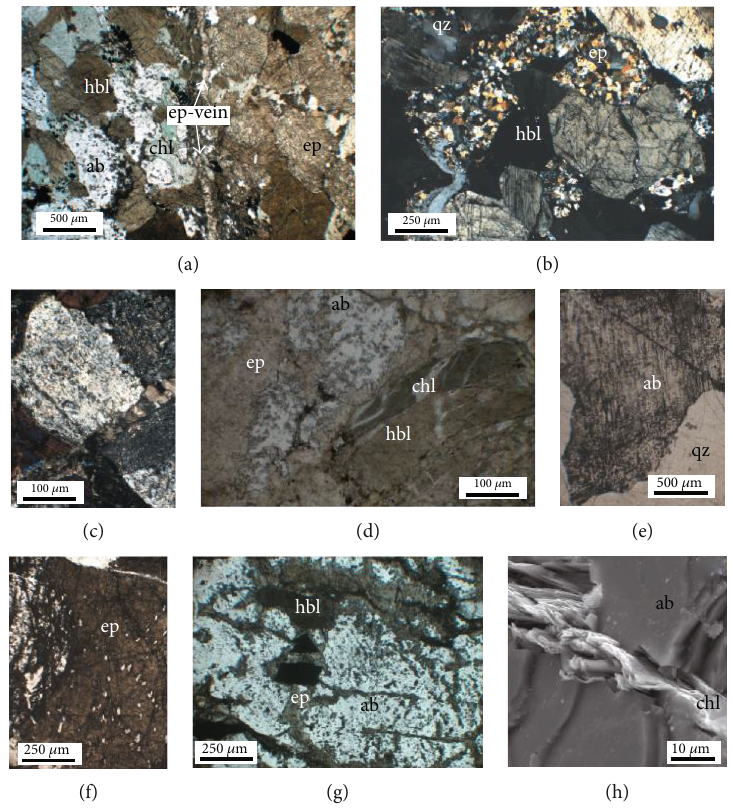
Figure 7: Photomicrographs of pervasive alteration textures in the gneiss. (a) Epidote vein marking sharply de fi ned boundary between plagioclase (albite)-rich gneiss to the left and epidote-rich gneiss to the right (thin section I3) (PPL); (b) granular textured epidote replacement texture within granoblastic gneiss (thin section AH1) (XPL); (c) sericitization of plagioclase (thin section S) (XPL); (d) marginal alteration of albite to epidote along minor fractures and grain boundaries at margins of epidosite (thin section I) (PPL); (e) alteration of coarse-grained albite plagioclase within pegmatite to fi ne-grained epidote along feldspar twin planes (thin section F) (PPL); (f) complete alteration of coarse-grained plagioclase at the margin of pegmatite to a combination of fi ne-grained epidote and small elongate quartz “ blebs ” (thin section F). Adjacent albite has cataclastic texture (PPL); (g) relict plagioclase within epidote gneiss and large deformed hornblende with minor marginal alteration to chlorite (thin section I) (PPL); (h) secondary electron image of plagioclase grain boundary with thin sheets of chlorite coating the boundary (sample